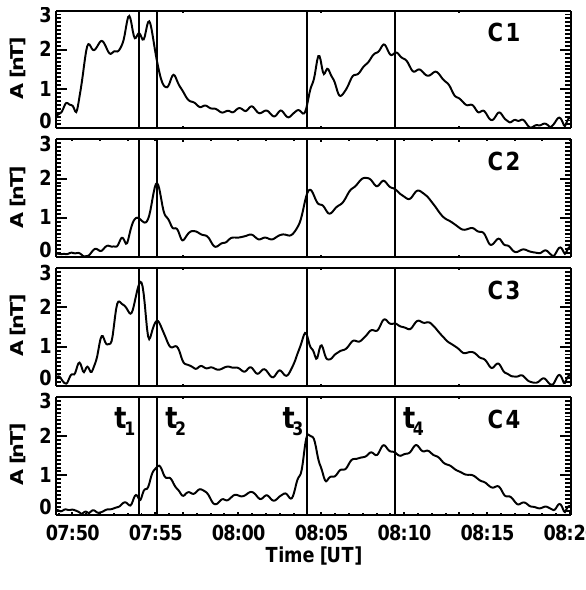
Fig. 7. Instantaneous amplitude A(t) of the transverse magnetic field